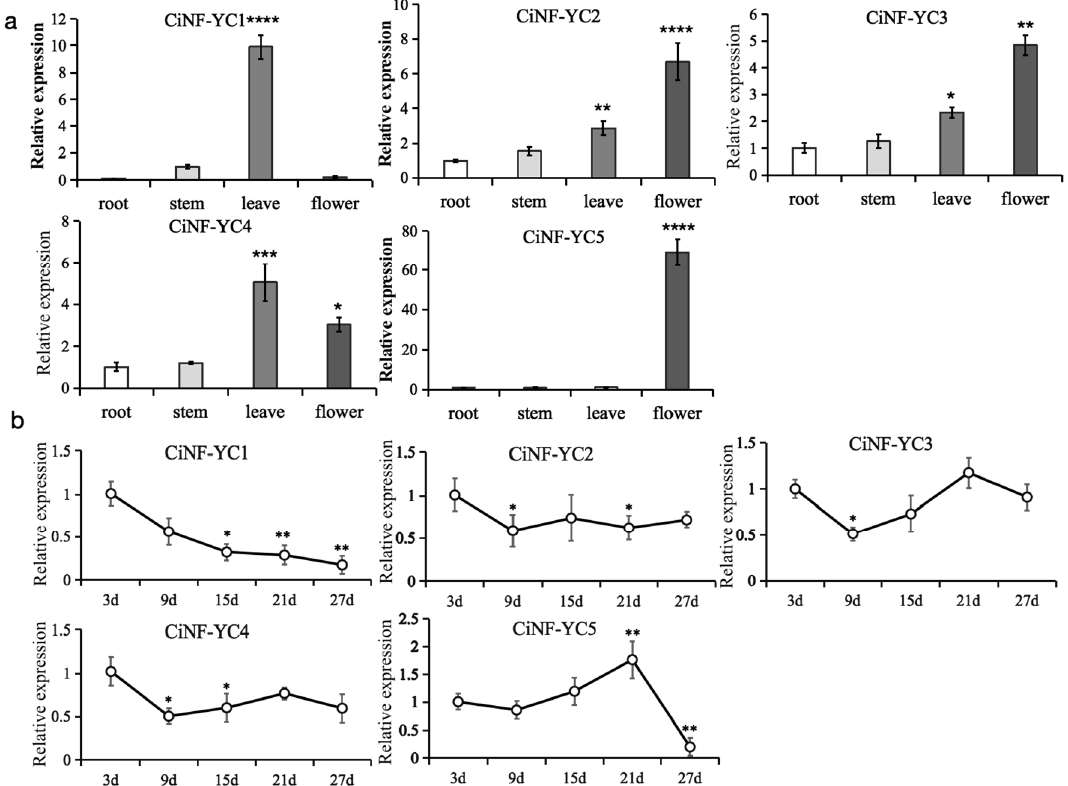
Figure 3. Transcript abundance of CiNF-YCs in different tissues and developmental stages. ( a ) Tran- script abundance of CiNF-YCs in different tissues. After 52 days of induction under SD conditions, the plants at full flowering stage were sampled. RT-qPCR was performed to evaluate expression of CiNF-YCs , using Actin (GenBank accession AB770470) as the control. For CiNF-YC1 , each tissue was compared to the stem. For other CiNF-YC genes, each tissue was compared to the root. ( b ) Transcript abundance of CiNF-YCs in leaves of differently aged wild chrysanthemums. Plants were grown under SD conditions. Samples were harvested every 6 days from 3 days after propagation. RT-qPCR was performed, and each time point was compared to 3d. Three independent experiments were performed, and error bars indicate standard deviation. * p < 0.05, ** p < 0.01, *** p < 0.001, and **** p < 0.0001 indicate significant